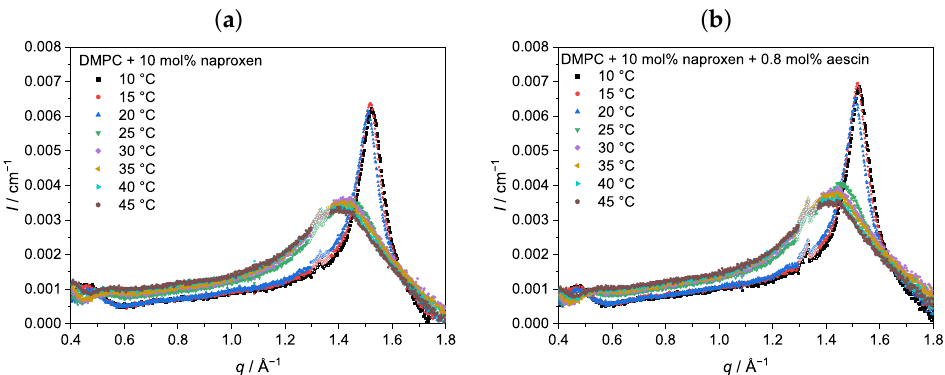
Figure 3. WAXS curves of DMPC vesicles with ( a ) 10mol% naproxen and ( b ) 10mol% naproxen and 0.8mol% aescin at different temperatures. The maximum of the WAXS signal shifted to lower q -values with increasing temperature. The open circles around 1.3Å − 1 mark artifacts that were not considered for